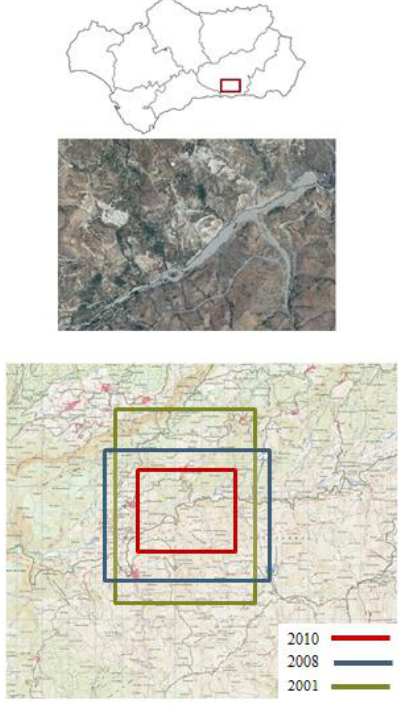
Figure 1: Study Area